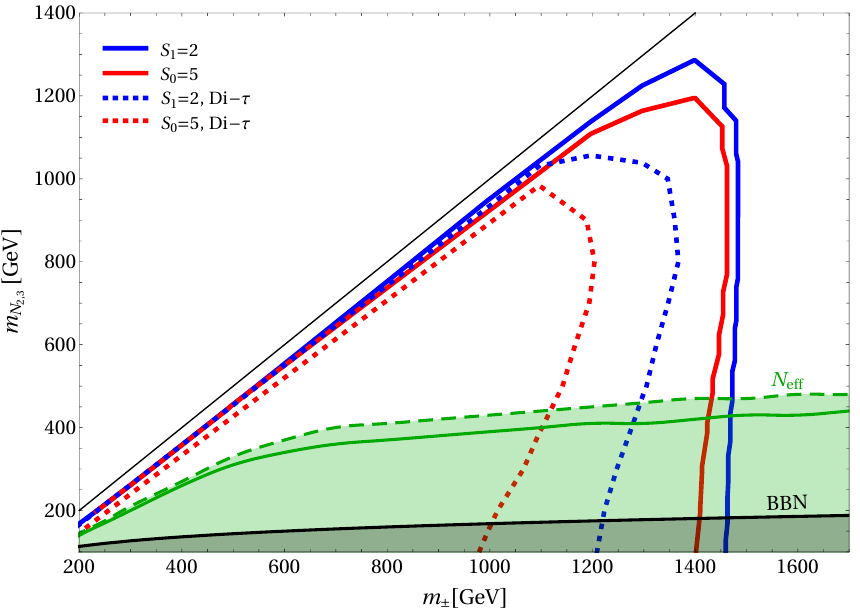
Figure 10 . CLIC sensitivity for the di-lepton search. Using maximized couplings to e; (cid:22) we obtained the red solid contour that corresponds to a 5 (cid:27) discovery and the blue one that represents 2 (cid:27) exclusion. The corresponding dashed contours are for the case where (cid:28) couplings are maximized. The thin black line indicates m N = m . We assumed an background uncertainty of 0 : 2 ; 3 (cid:6)